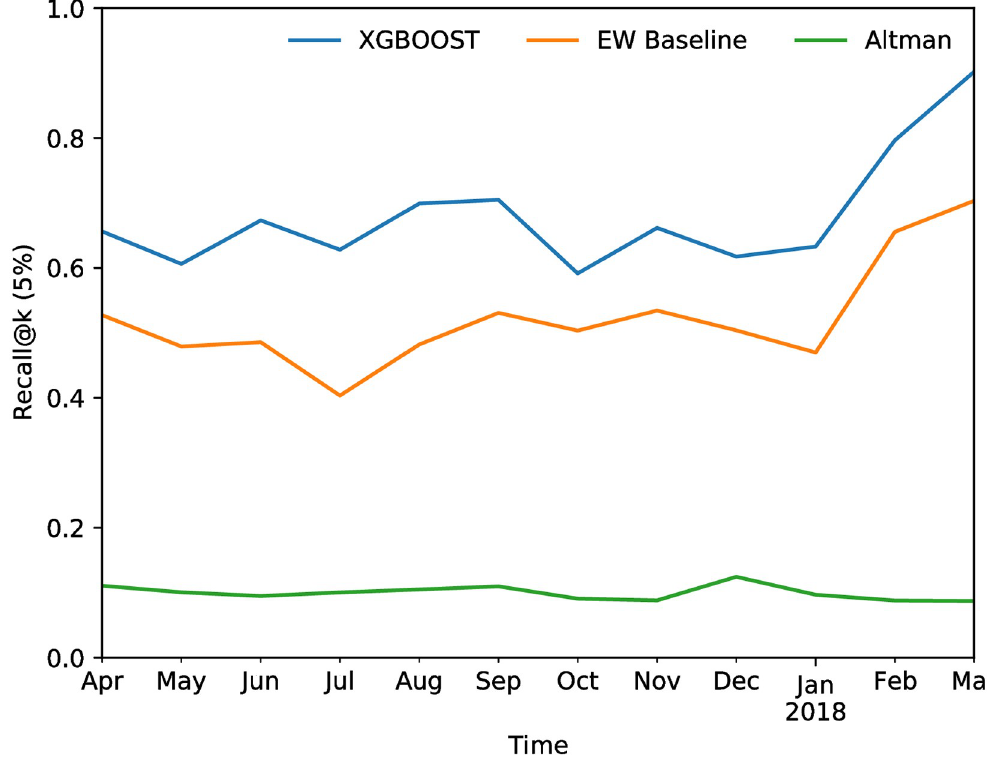
Fig 11. Recall@K for the XGBoost model with mixed single-firm and network features as a function of time in the prequential setting compared to a logistic regression model on single-firm features (baseline). The average R@K is 68.1% and the AUC is 90.5%.